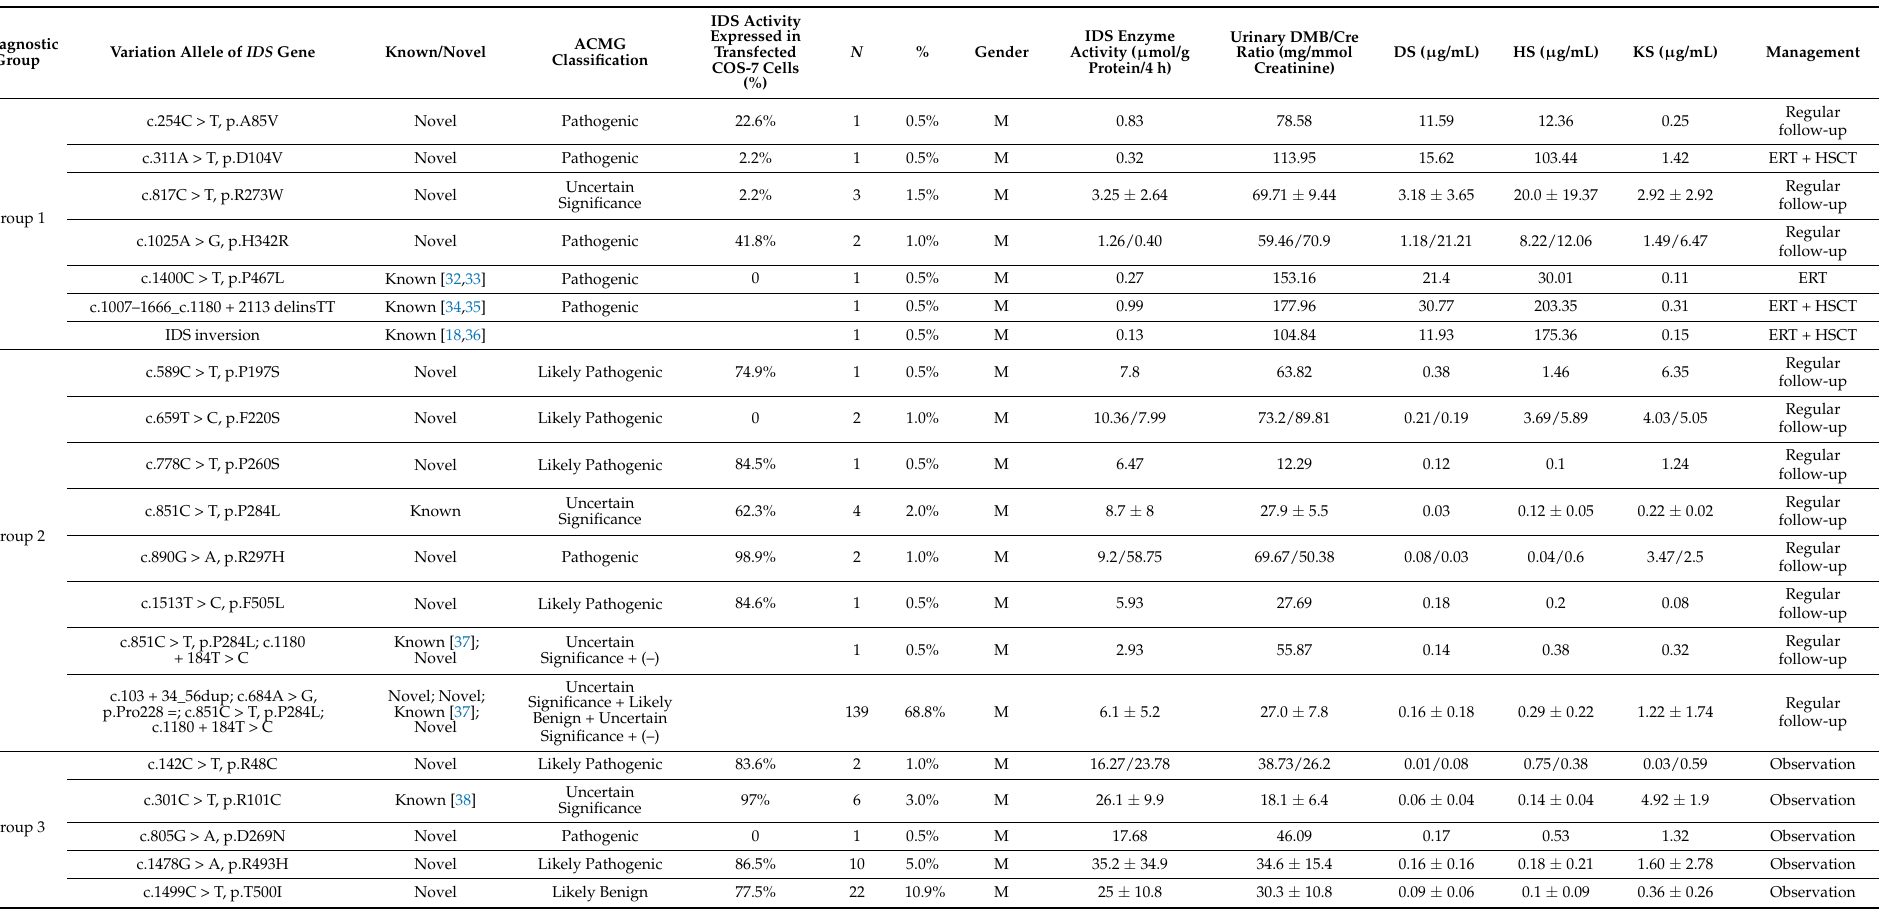
Table 1. Variation alleles of the IDS gene, IDS enzyme activity, biochemistry GAG tests, and management of the 202 referred subjects from our MPS II newborn